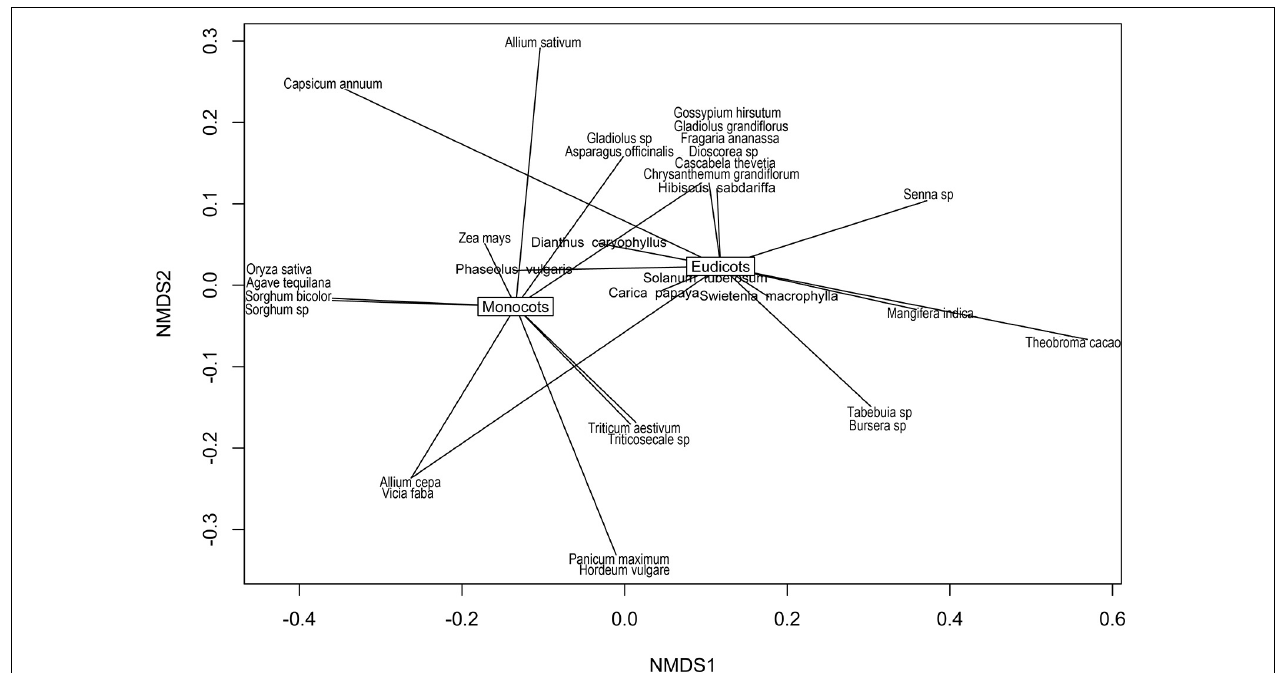
FIGURE 4 | Non-Metric Multidimesional Scaling ordination mapping host species dissimilarities in terms of their pathogenic fusaria species. The squares show the centroids corresponding the distribution of Monocots and Dicot species. Species: Agave tequilana (agateq), Allium cepa (allcep), Allium sativum (allsat), Asparagus officinalis (aspoff), Bursera sp. (bursp), Capsicum annuum (capann), Carica papaya (carpap), Cascabela thevetia (casthe), Chrysanthemum grandiflorum (chrgra), Dianthus caryophyllus (diacar), Dioscorea sp. (diosp), Fragaria ananassa (fraana), Gladiolus grandiflorus (glagra), Gladiolus sp. (glasp), Gossypium hirsutum (goshir), Hibiscus sabdariffa (hibsab), Hordeum vulgare (horvul), Mangifera indica (manind), Oryza sativa (orysat), Panicum maximum (panmax), Phaseolus vulgaris (phavul), Senna sp. (sensp), Solanum tuberosum (soltub), Sorghum bicolor (sorbic), Sorghum sp. (sorsp), Swietenia macrophylla (swimac), Tabebuia sp. (tabsp), Theobroma cacao (thecac), Triticum aestivum (triaes), Vicia faba (vicfab), xTriticosecale sp. (xtrsp), Zea may (zeamay). The enlisted plants included species, morpho species of known genera (e.g., Bursera sp., Senna sp., and Tabebuia sp.) and cultivated varieties ( Gladiolus sp. and Sorghum sp.). Only fusaria species with known identity were considered in the